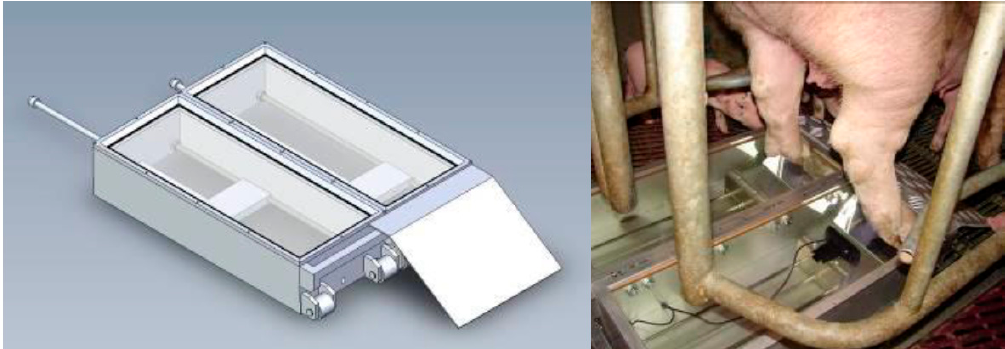
Figure 3. The third prototype of the Mobile Claw Scoring Device (MCSD) presented via the CAD-software ( left ) and at the first trial in the farrowing crates on the ILVO experimental farm ( right ).